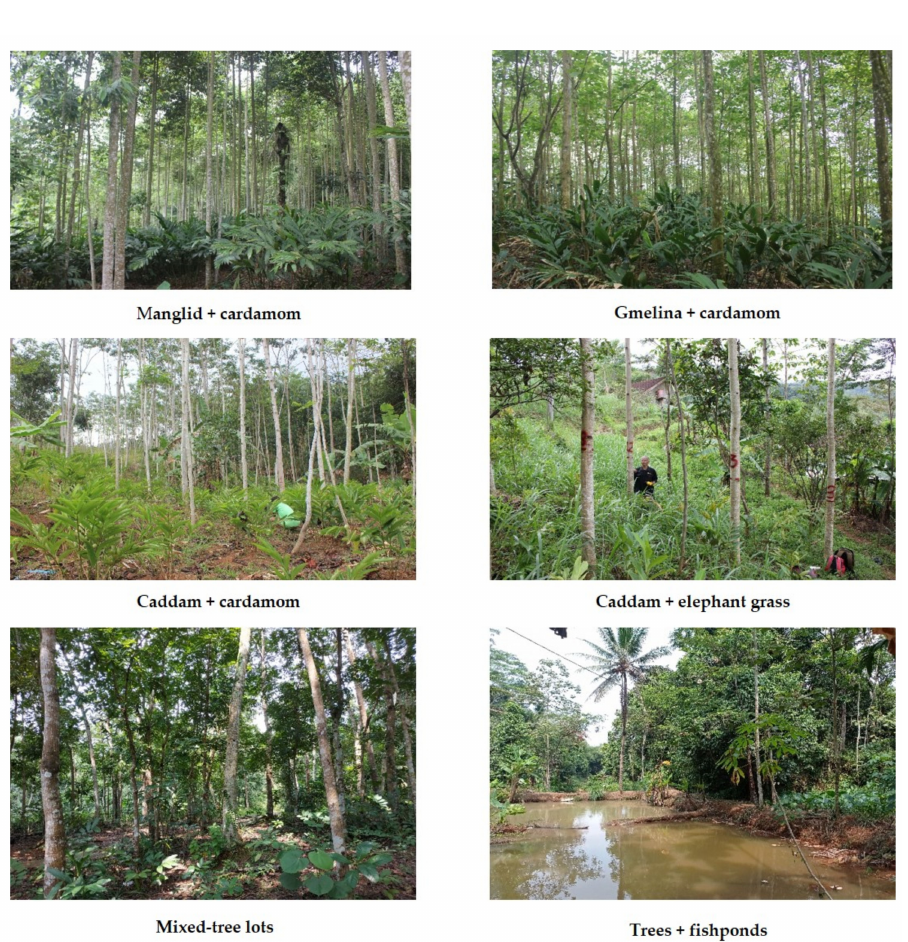
Figure 2. Common agroforestry systems in the study sites in West